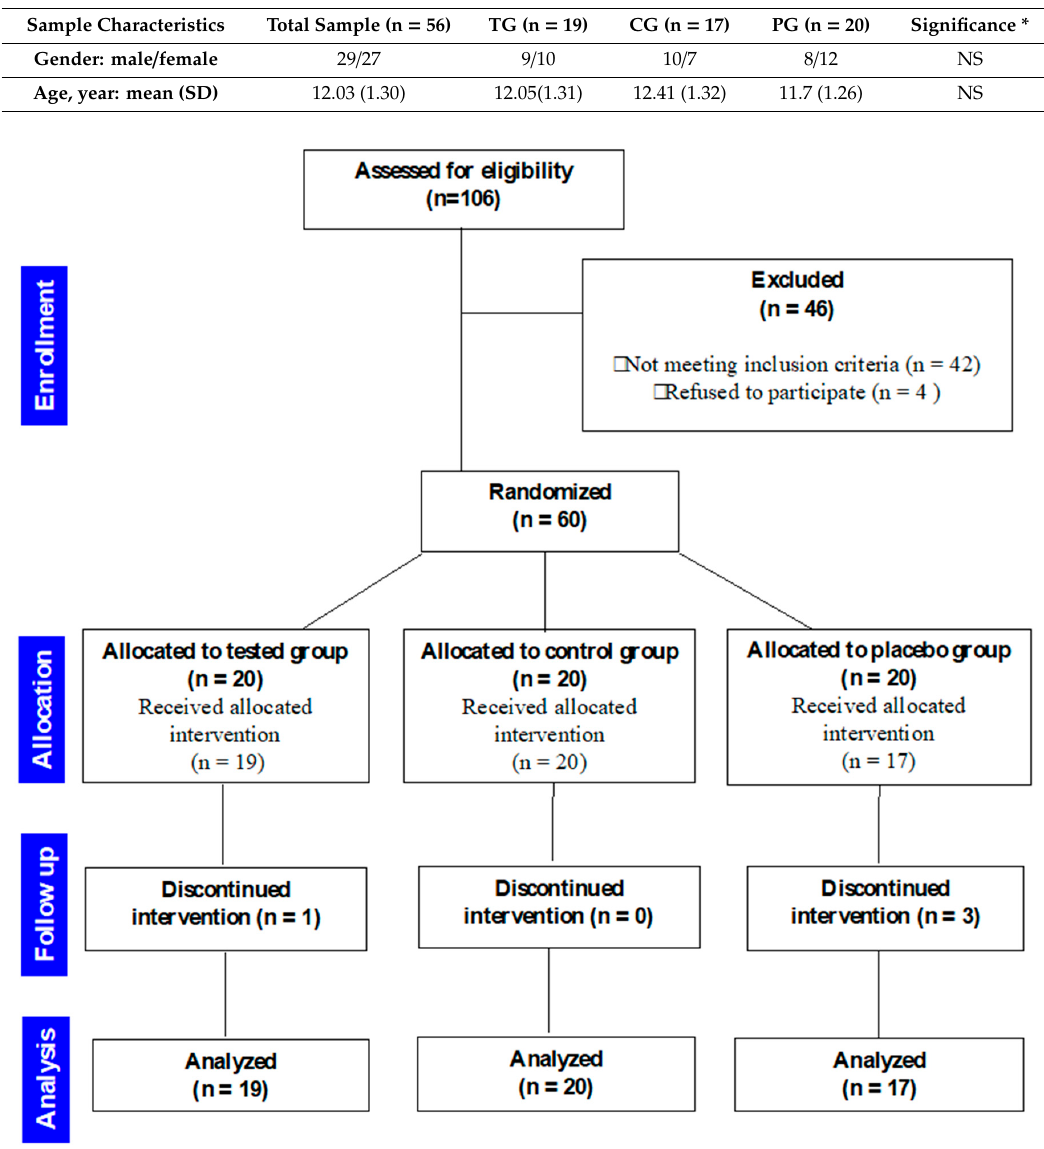
Table 1. Demography, clinical characteristics and descriptive statistics of the study sample. TG = Tested group, CG = Control Group, PG = Placebo Group. * p -value set as ≤ 0.05. Assessed by paired t - test or chi-square test. NS = not significant.